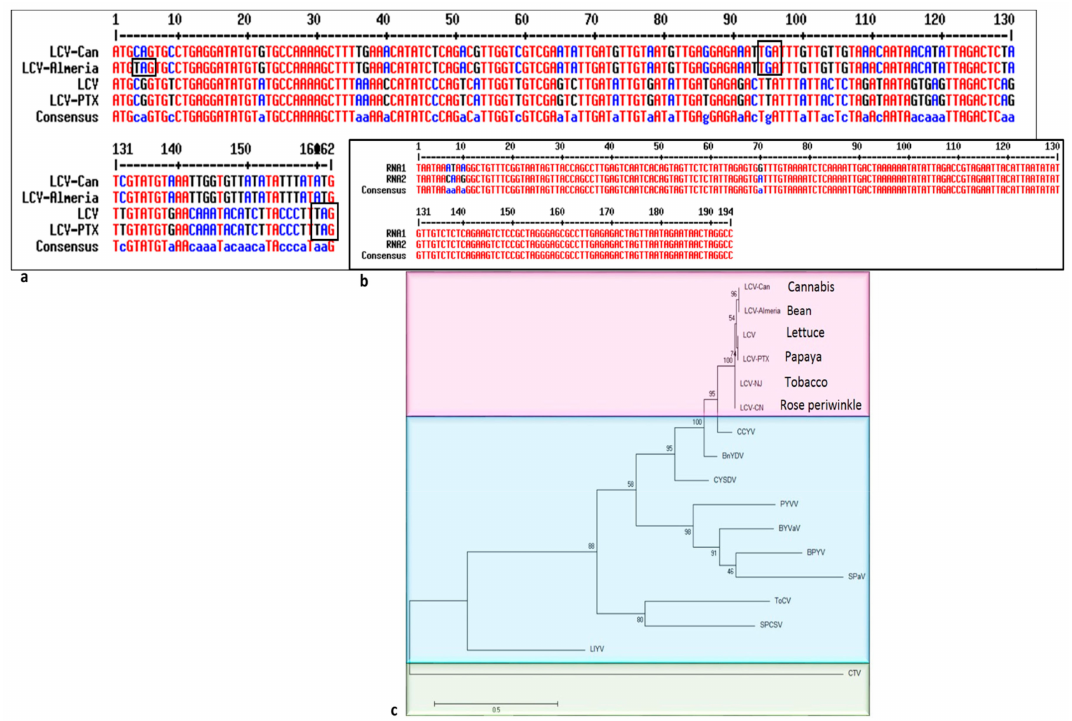
Figure 3. Nucleotide sequence alignment of lettuce chlorosis virus (LCV) P6-like protein and 3 (cid:48) UTRs of RNA1 and RNA2 fragments and phylogenetic analysis of LCV-Can. ( a ) P6-like putative protein encoded by RNA2 of 4 LCV isolates: LCV-Can, accession No. MK747246, LCV-Almeria, accession No. MG489895, LCV (California), accession No. FJ380119 and LCV-PTX, accession No. KY271956. ( b ) 3